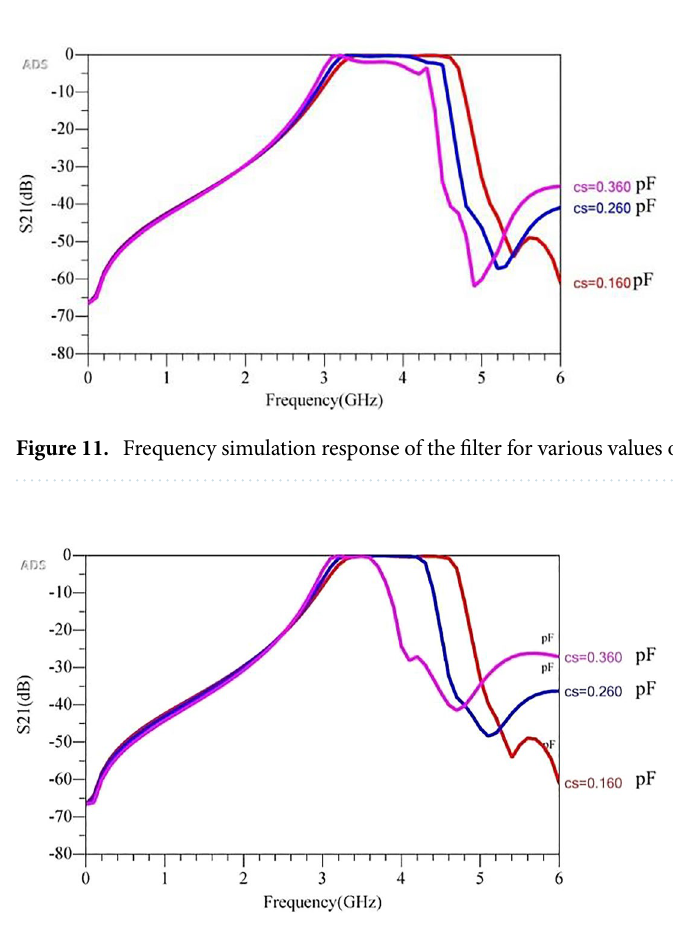
Figure 12. Frequency response simulation of the proposed filter for multiple optimized values of Cs and